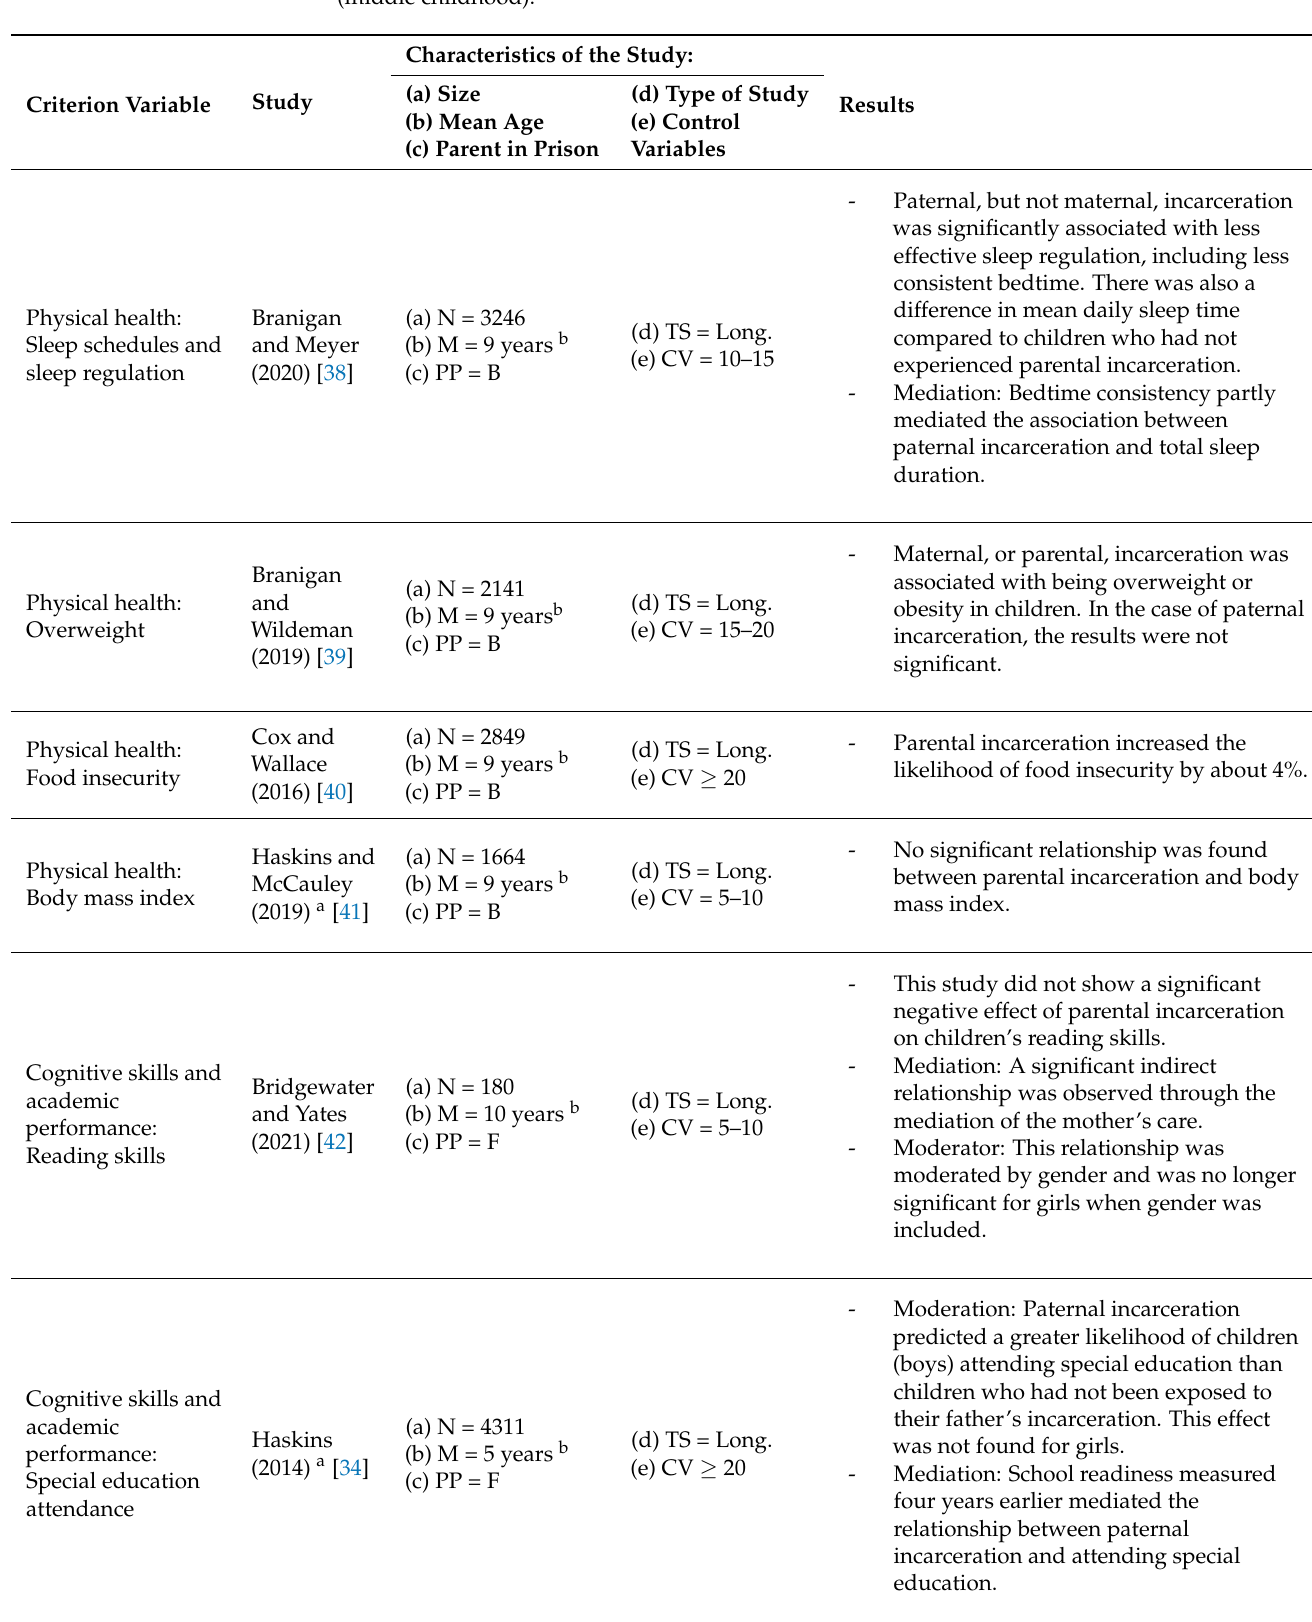
Table A2. Summary of studies included in the systematic review. Children aged 7 to 11 years old (middle